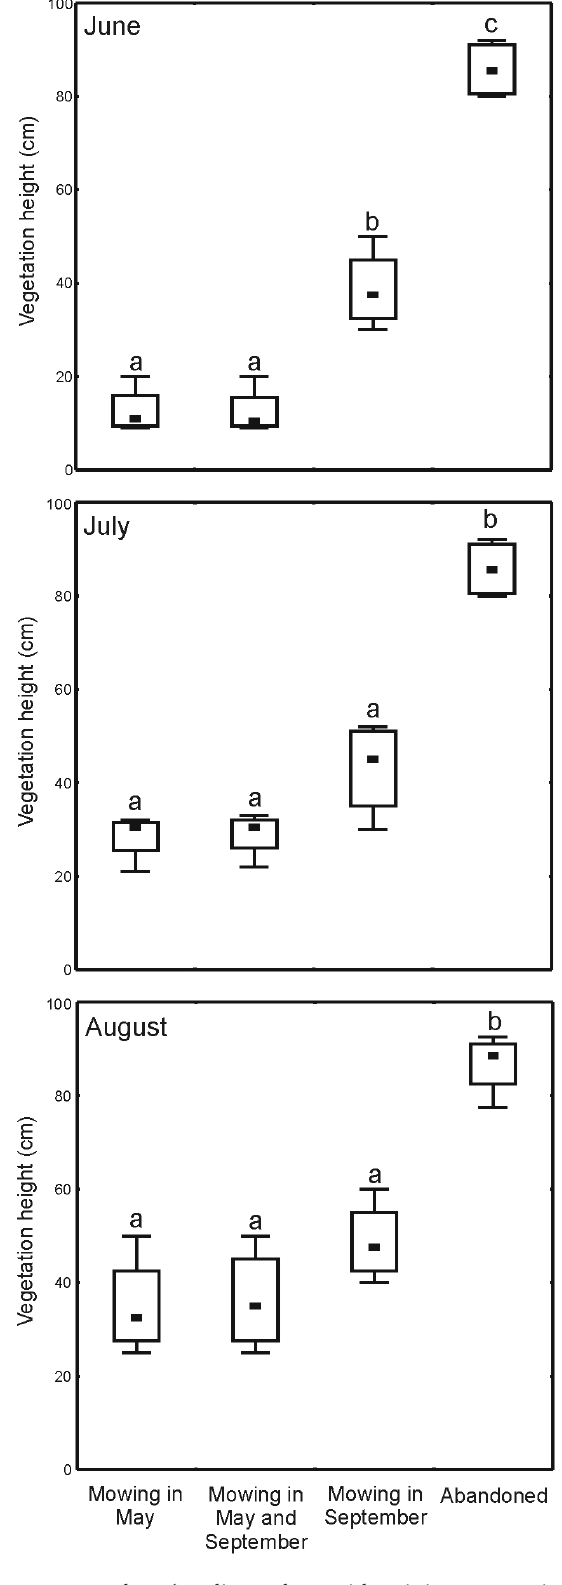
Figure 2. Box-plots (median values with minimum, maximum and ±SE) of vegetation height in four treatment types. Significant (p<0.05) differences detected by Mann-Whitney U test are indi- cated by different letters.